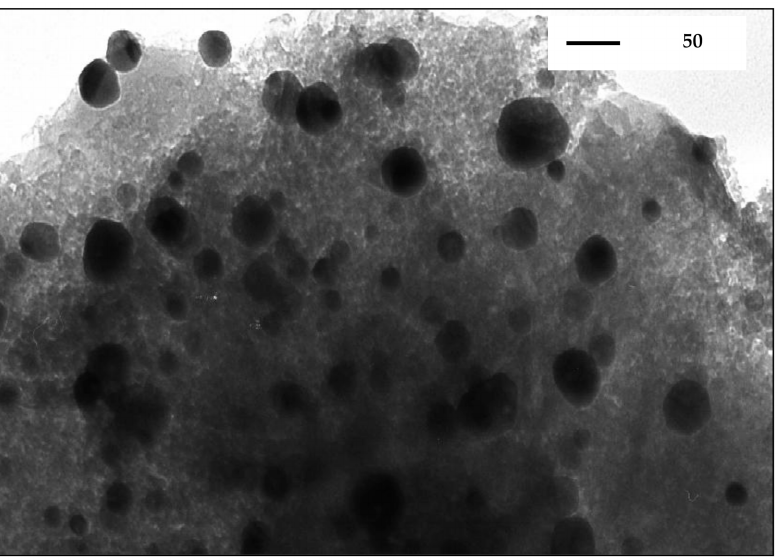
Figure 16. Transmission electron microscopy image of used Ni-montmorillonite at 40,000 × .